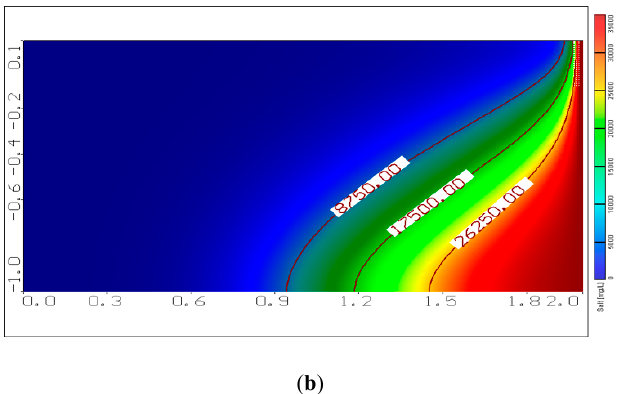
Figure 16. SWI due to increasing saltwater head ( a ) and decreasing freshwater ( b ) .